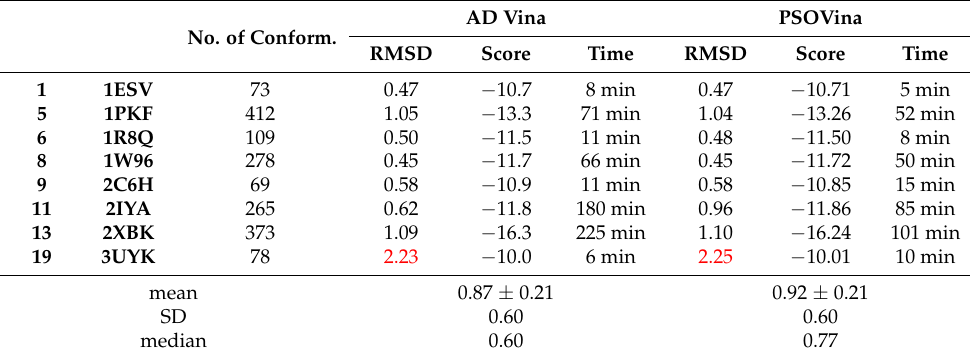
Table 3. Comparison of AD Vina and PSOVina results for the lowest-energy conformers of the macrolide subset.